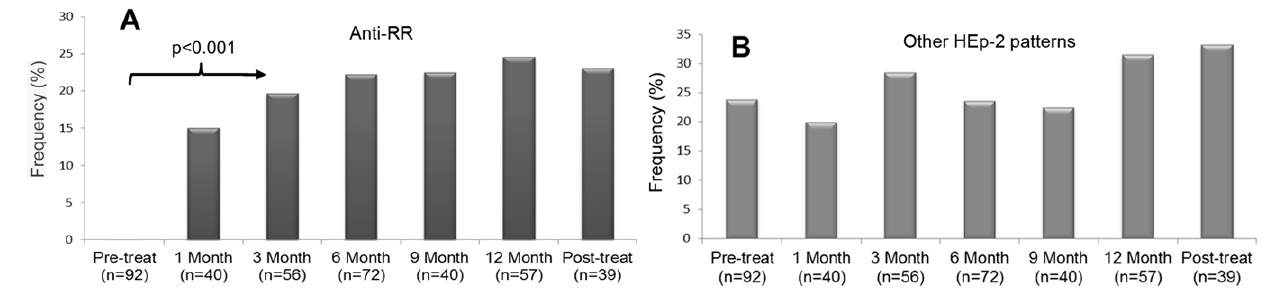
Figure 3. Anti-RR reactivity occurs at varying intervals after the beginning of treatment. Samples from HCV patients were obtained at baseline, at successive months after beginning of treatment with interferon- a plus ribavirin, and 6–12 months after treatment discontinuation. (A) Anti-RR was absent in samples obtained at the beginning of treatment and there was a clear trend for increasing frequency in samples obtained along several time points during and after treatment; the frequency rate differed between the pre-treatment bleed and other time points, but not among the several bleeds after the beginning of treatment (p=0.705). (B) The frequency of other IIF-HEp-2 patterns was equivalent in samples obtained before the beginning of treatment and in those obtained along and after the treatment